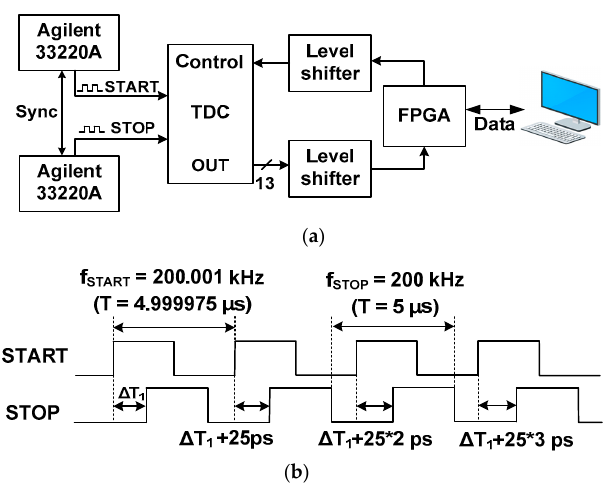
Figure 15. ( a ) Measurement setup, ( b ) time sweep method.